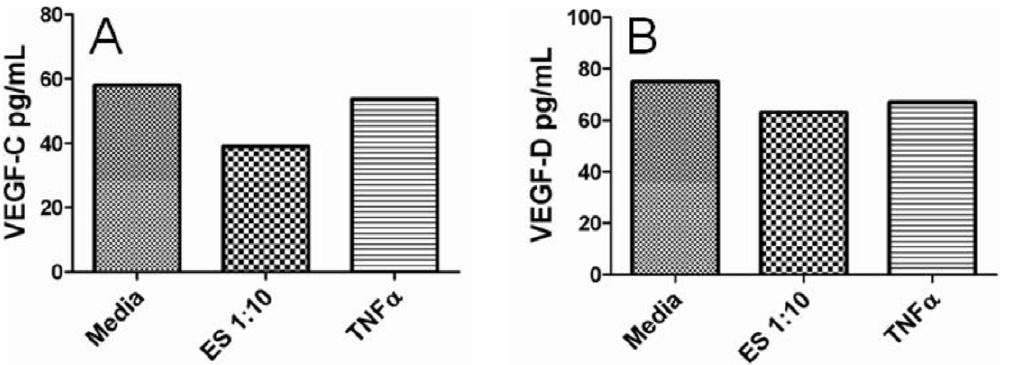
Figure 3. Growth factor production by LECs in response to filarial ES products. 2 6 10 4 LECs were plated in EGM-2MV media and allowed to adhere for 24 hours. Cells were then starved for 24 hours in MCDB-131 media prior to stimulation for 24 hours in EGM-2MV media with or without ES (1:10) or TNF a (10 ng/mL). Supernatants were harvested and assessed for growth factor production including VEGF-C (A) and VEGF-D (B) by ELISA. Experiments were completed in triplicate and this figure includes representative data from one experiment.